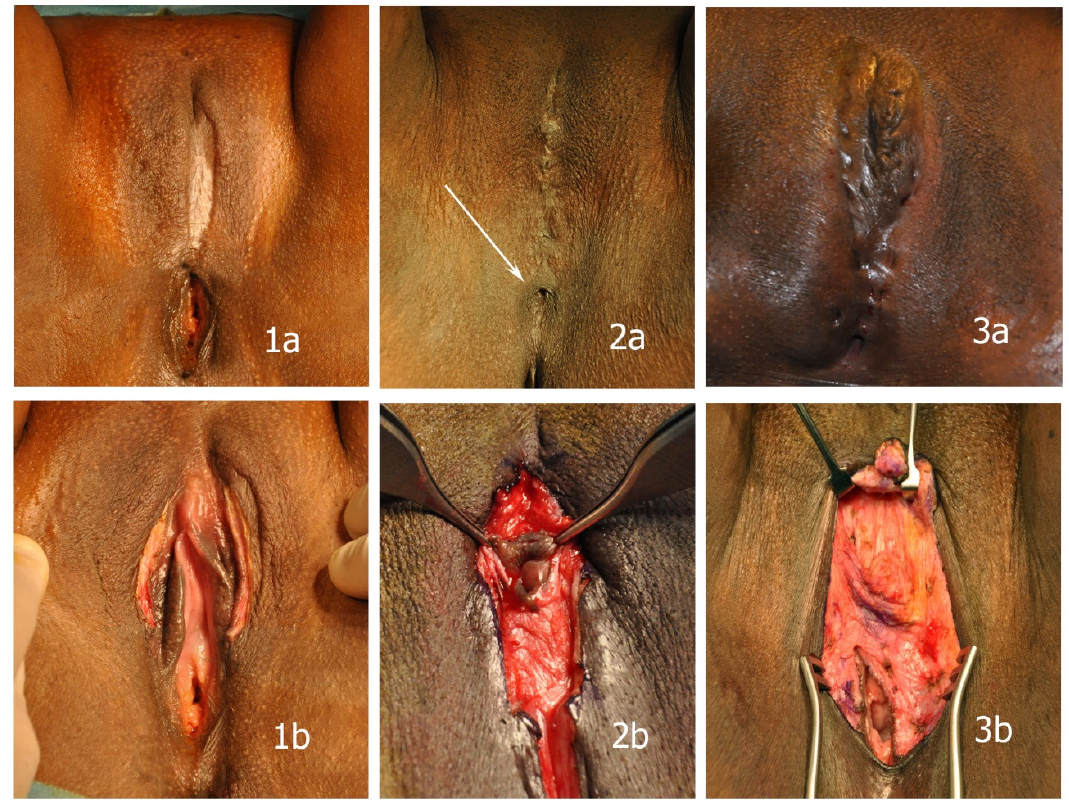
Figure 1. In spite of considerable differences in the extent of the mutilations, all cases shown are classified as Type IIIb mutilations according to the present WHO classification. ( 1a , 1b ) partial deinfibulation before sexual intercourse with almost unharmed minor labia and clitoris underneath the scar; ( 2a , 2b ) minimal opening left after infibulation (arrow) and unharmed clitoris in a small cyst encapsulated in scar tissue with resected minor labia; ( 3a , 3b ) extensive fistulae after suturing that required excision prior to reconstruction; resected clitoral glans and labia.